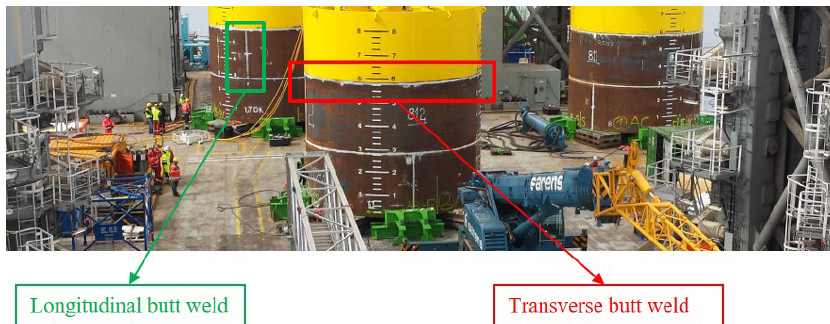
Figure 18. Monopile welded connections (twd, 2019).